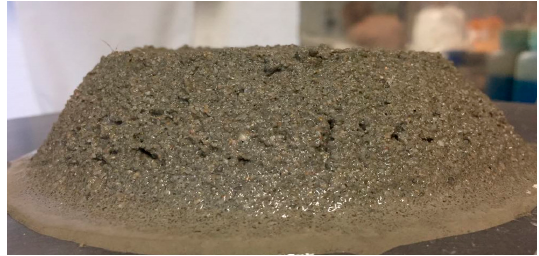
Figure 3. Flow table test for the modified mortar.